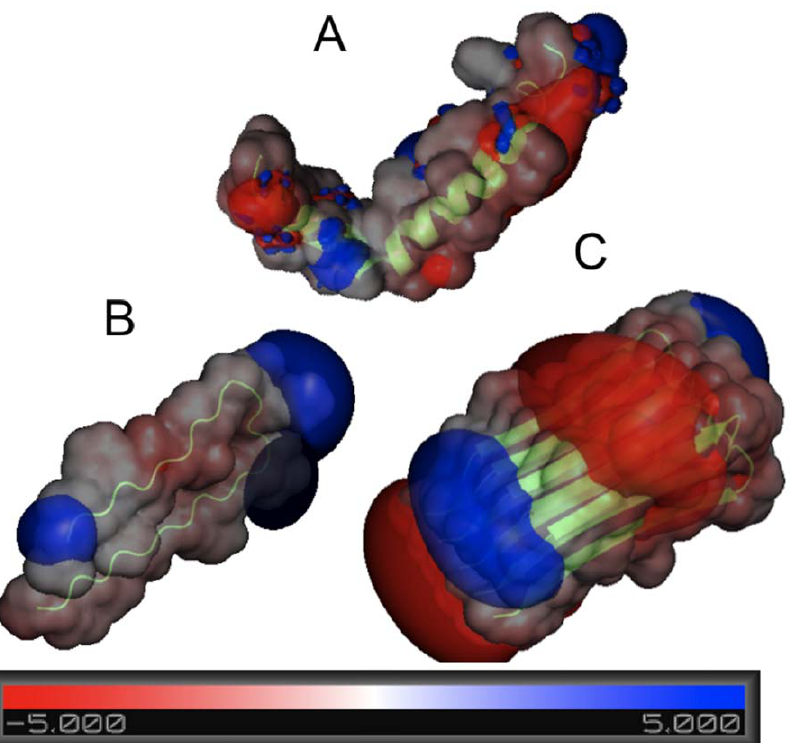
Figure 5. Electrostatic potentials of amyloid monomers and oligomers. The 5kT and -5kT isoelectric potential surfaces are superimposed on the molecular surface. Positive charge is shown in blue, and negative in red. The molecular surface is produced by convolving a 1.4A˚ sphere (which represents a water molecule) around each peptide. The (A) alpha helix monomer does not have any strongly charged regions, whereas the (B) beta sheet monomer has a strong positively charged end. In comparison, the (C) stack of 5 beta sheets has 4 strongly charged regions, which would greatly contribute to electrostatic interactions with charged surfaces. Images were produced using PyMOL v1.2.